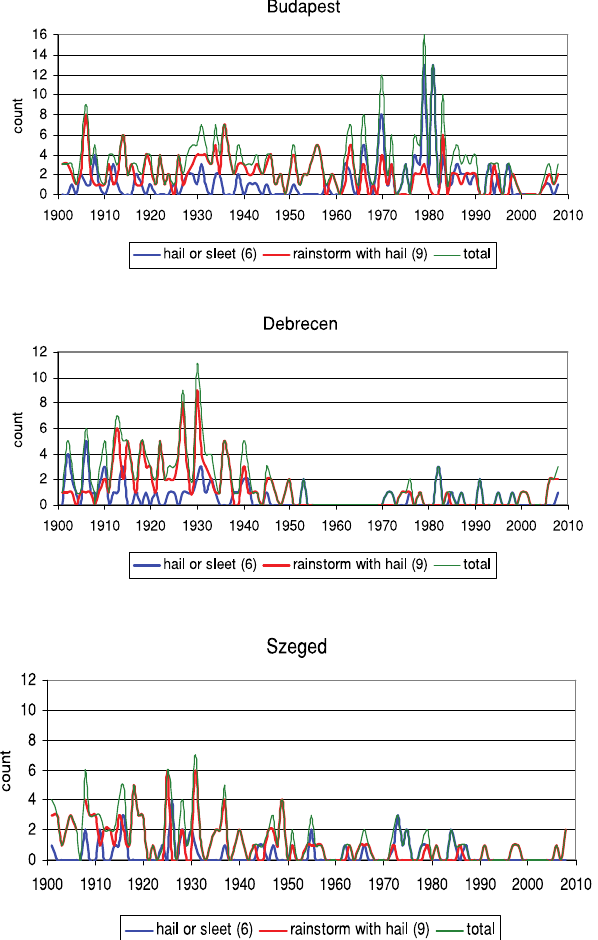
Figure 1: Hail events in the time interval 1901–2008